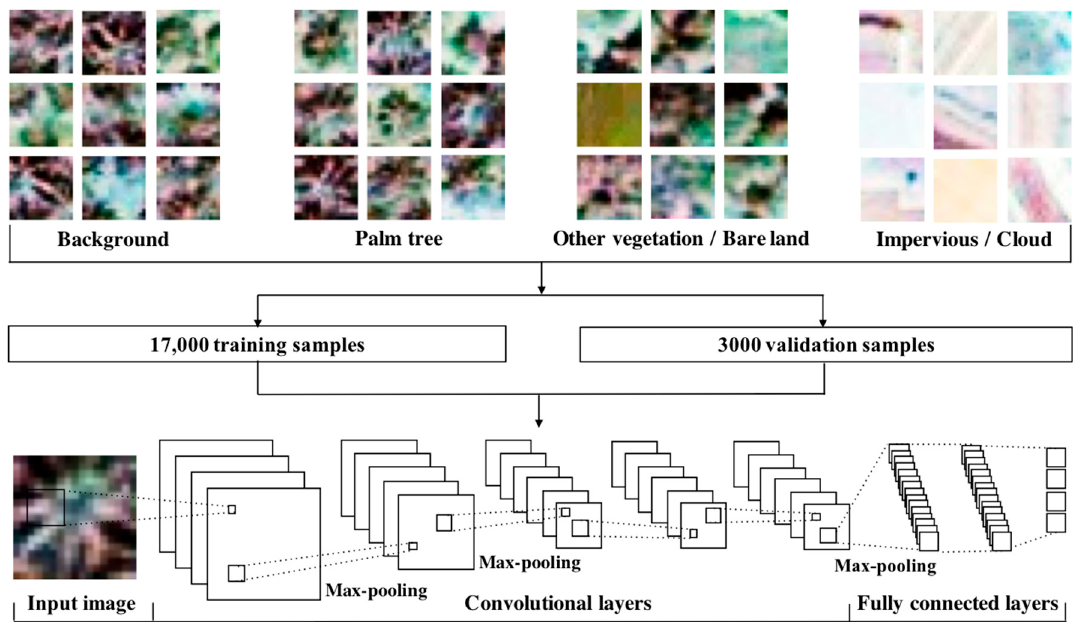
Figure 4. The framework of the CNN for object classification.